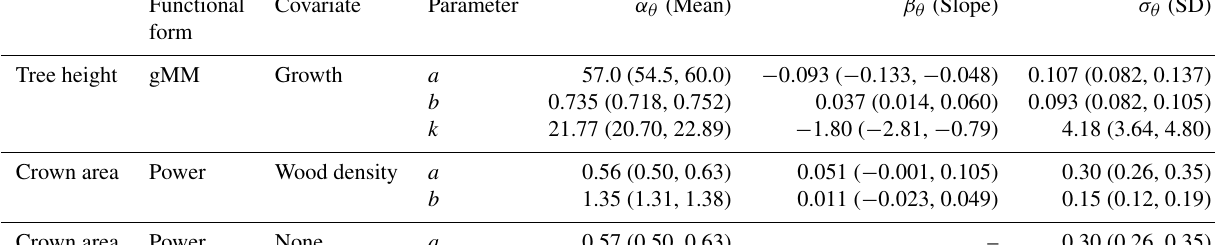
Table 2. Posterior estimates of the parameters of the best hierarchical models for tree height and crown area allometries (see Table 1). Table entries correspond to the mean and 90% posterior central intervals for the community-level parameters of each allometric function (see Eqs. 2–4 in Methods). Tree height allometry was best described by a generalized Michaelis–Menten (gMM) model including the effect of the natural logarithm of sapling growth rate (growth). The scaling of crown area was best described by a power law function, with similar performance between a model with no covariates and one with parameters varying depending on species wood density (Table 1). Covariates were centered and scaled before the analysis to ease comparisons of effects (natural logarithm of sapling growth rate (%yr − 1 ); mean (SD) = 1 . 01 (0.65); wood density mean (SD) = 0 . 56 (0.14)gcm − 3 ) . The standard error, σ ν , of the best models were 0.181 (0.179, 0.183), 0.549 (0.536, 0.563), and 0.550 (0.536, 0.562) for tree height and the two models for crown area, including wood density or no covariate, respectively.